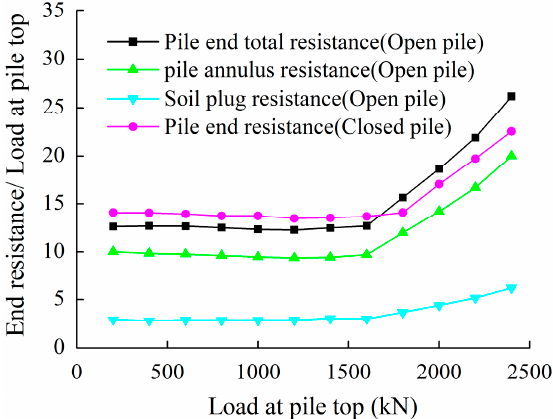
Figure 11. Change in the ratio of end resistance to load under loading.